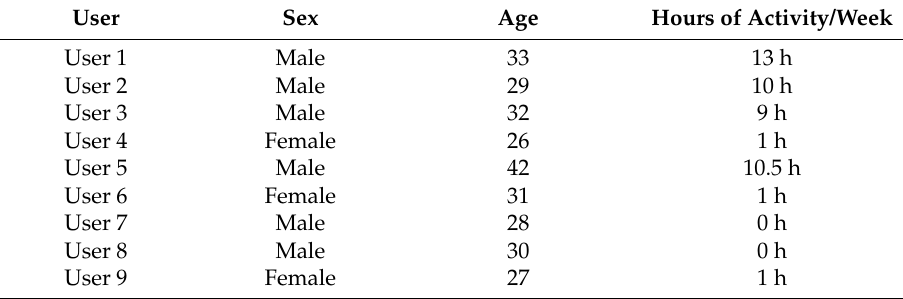
Table 3. Set of users for the case of